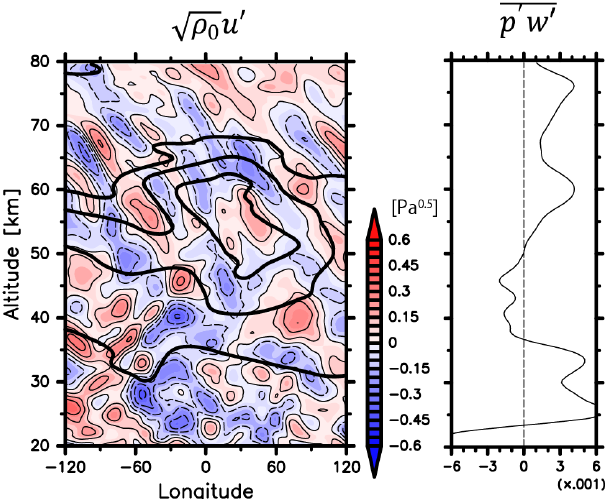
Figure 16. (a) A longitude–height cross section of zonal wind com- p ρ 0 u (cid:48) at 65 ◦ S at ponents of the large-scale inertia–gravity waves 15:00UTC, 18 March (contour interval 0.1Pa 0 . 5 ) , and (b) a line plot of the energy flux p (cid:48) w (cid:48) averaged from the longitude of − 90 ◦ E to the longitude of 60 ◦ E denoted by black arrows. The thick black contours show background zonal wind components extracted by a low-pass filter with a cutoff wavelength of 4000km. The thick con- tours denote 20, 30 and 40ms − 1 , respectively. The data are from the NICAM